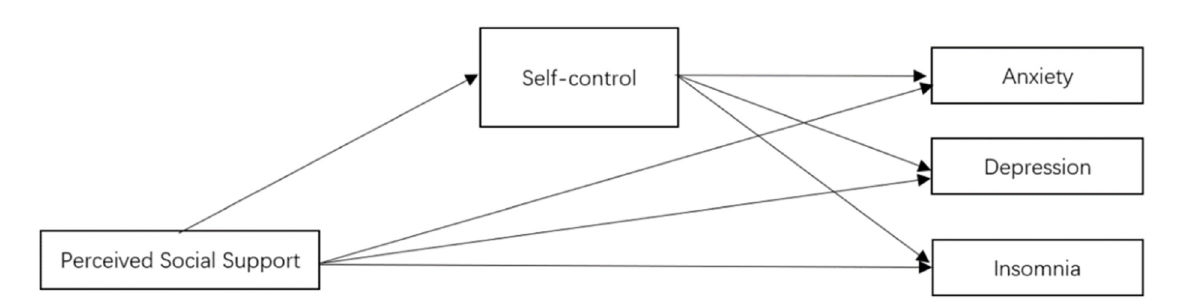
FIGURE1 The conceptual model, social support as the independent variable, self-control as the mediating variable, anxiety, depression, and insomnia as the dependent variables.